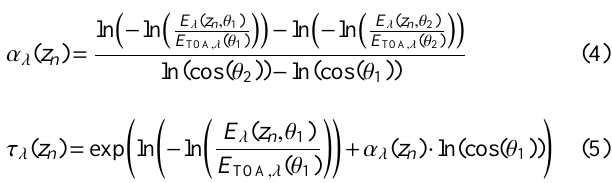
Figure 1. Errors in global total SSI (0 ◦ , 60 ◦